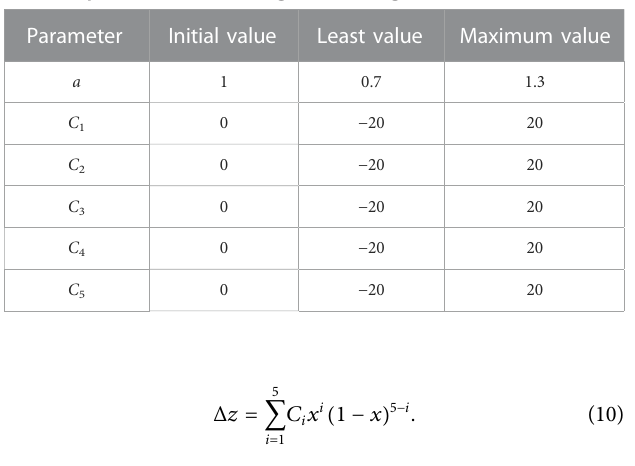
TABLE 2 Optimization variable ranges for conning tower.